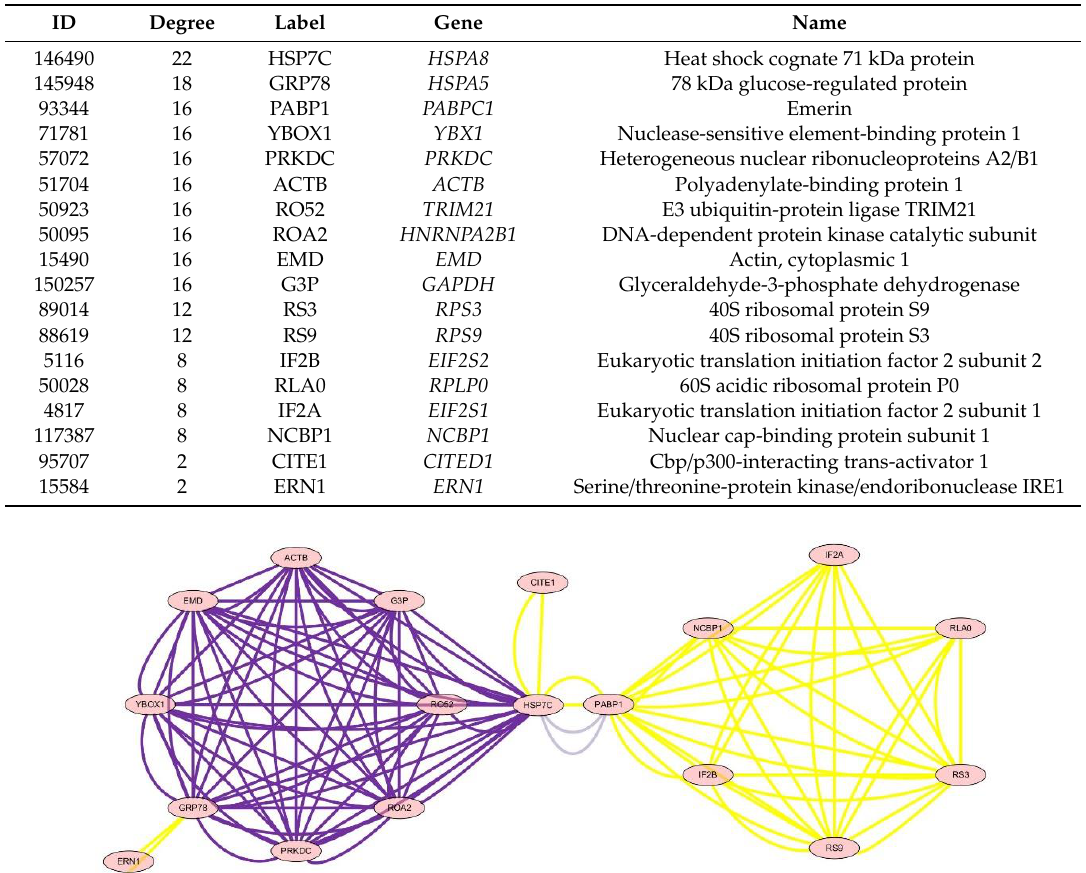
ff erential protein Figure 3. The network of differential protein expression. Figure 3. The network of di